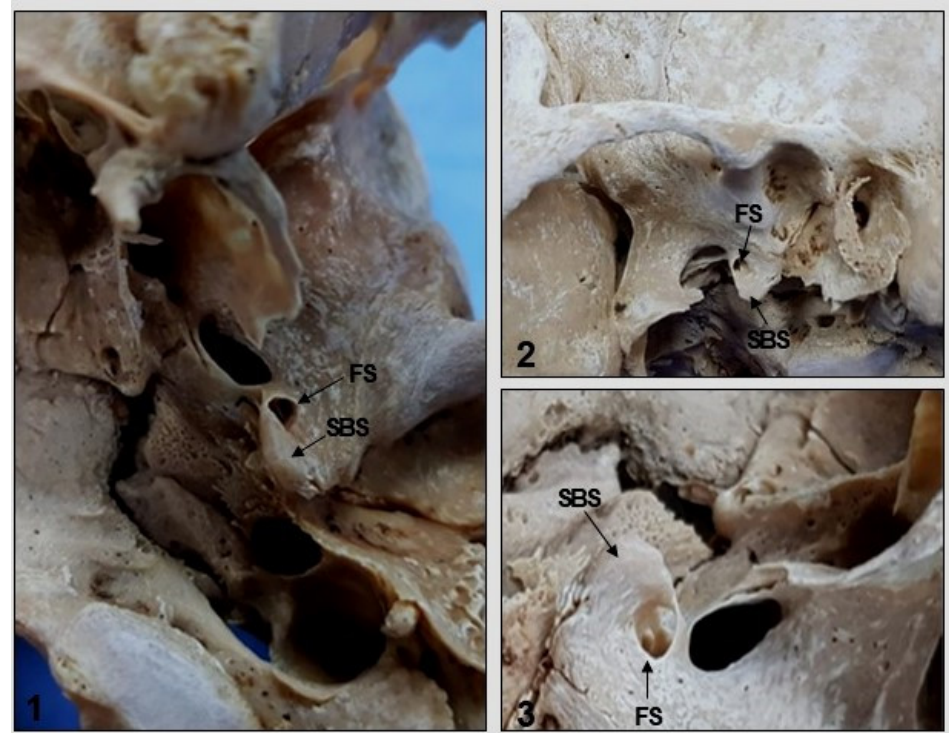
Figure 8. Inferior ( 1 ) and lateral ( 2 , 3 ) view of the skull. Note the medial position of the spine of the sphenoid bone (SBS) in relation to the foramen spinosum (FS).